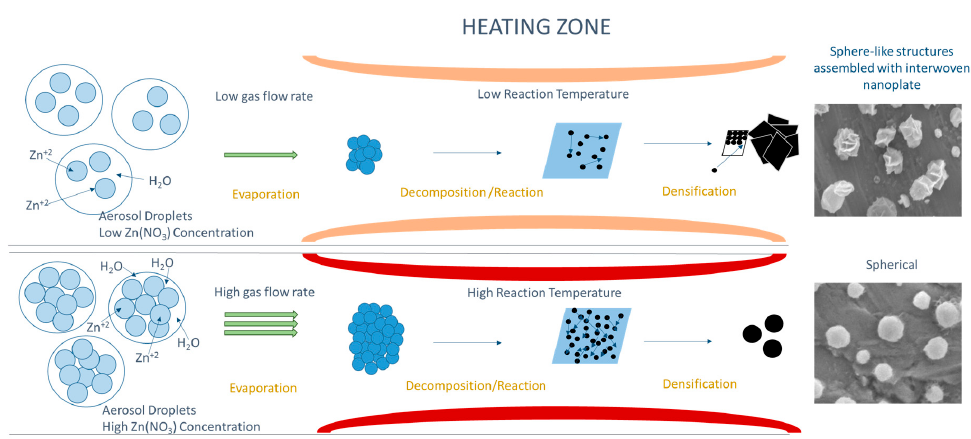
Figure 7. Schematic diagram of spherical and sphere-like structures assembled with interwoven nanoplate ZnO formation through Ultrasonic Spray Pyrolysis (USP).